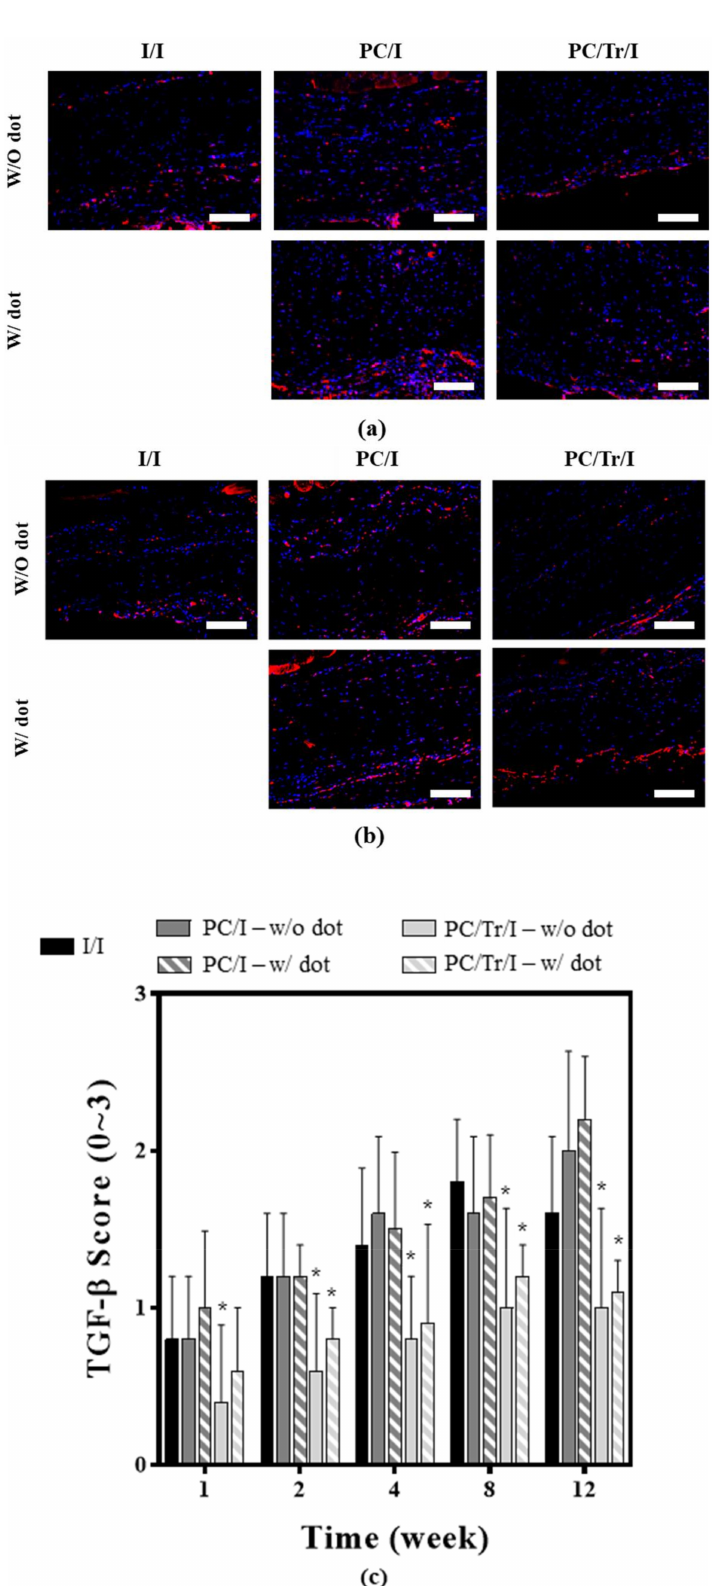
Figure 8. Evaluation of the TGF- β expression level 12 weeks after sample implantation. Representative IF-stained images of TGF- β expression at ( a ) 4 and ( b ) 12 weeks. Scale bars are 200 µ m. ( c ) Score profiles of TGF- β expression. * Statistically significantly difference from the I/I ( p < 0.05). Error bars are the standard